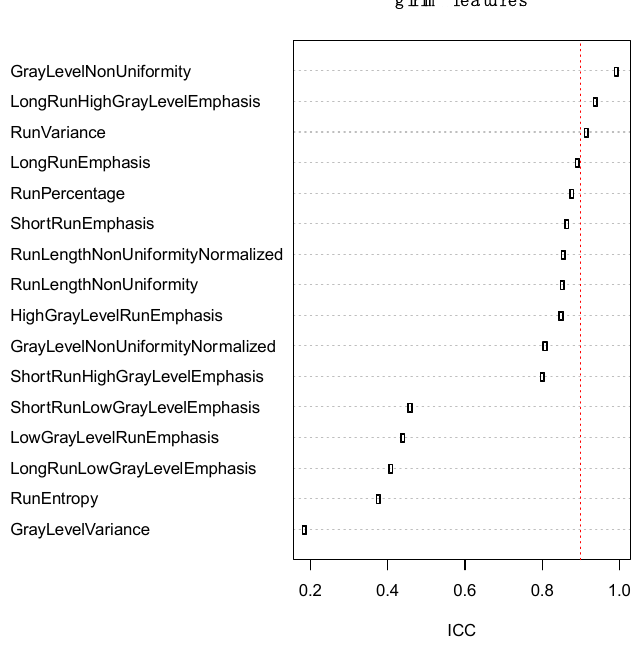
Figure 6. Robustness of second-order GLRLM features across segmentations. Pyradiomics computes 16 second-order GLRLM features. The robustness (ICC) is above 0.8, per all values of distance and binw, only for 11 of them. Robustness of many features across segmentations is dependent on bin-width but not on distance (the vertical dashed red line indicates the 0.9 threshold).